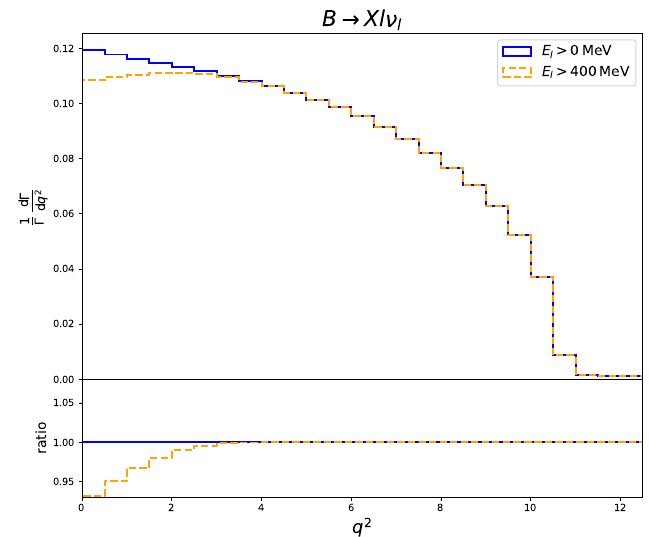
Figure 8: The q 2 spectrum in B → X l ν quirement on the lepton energy in the laboratory frame.